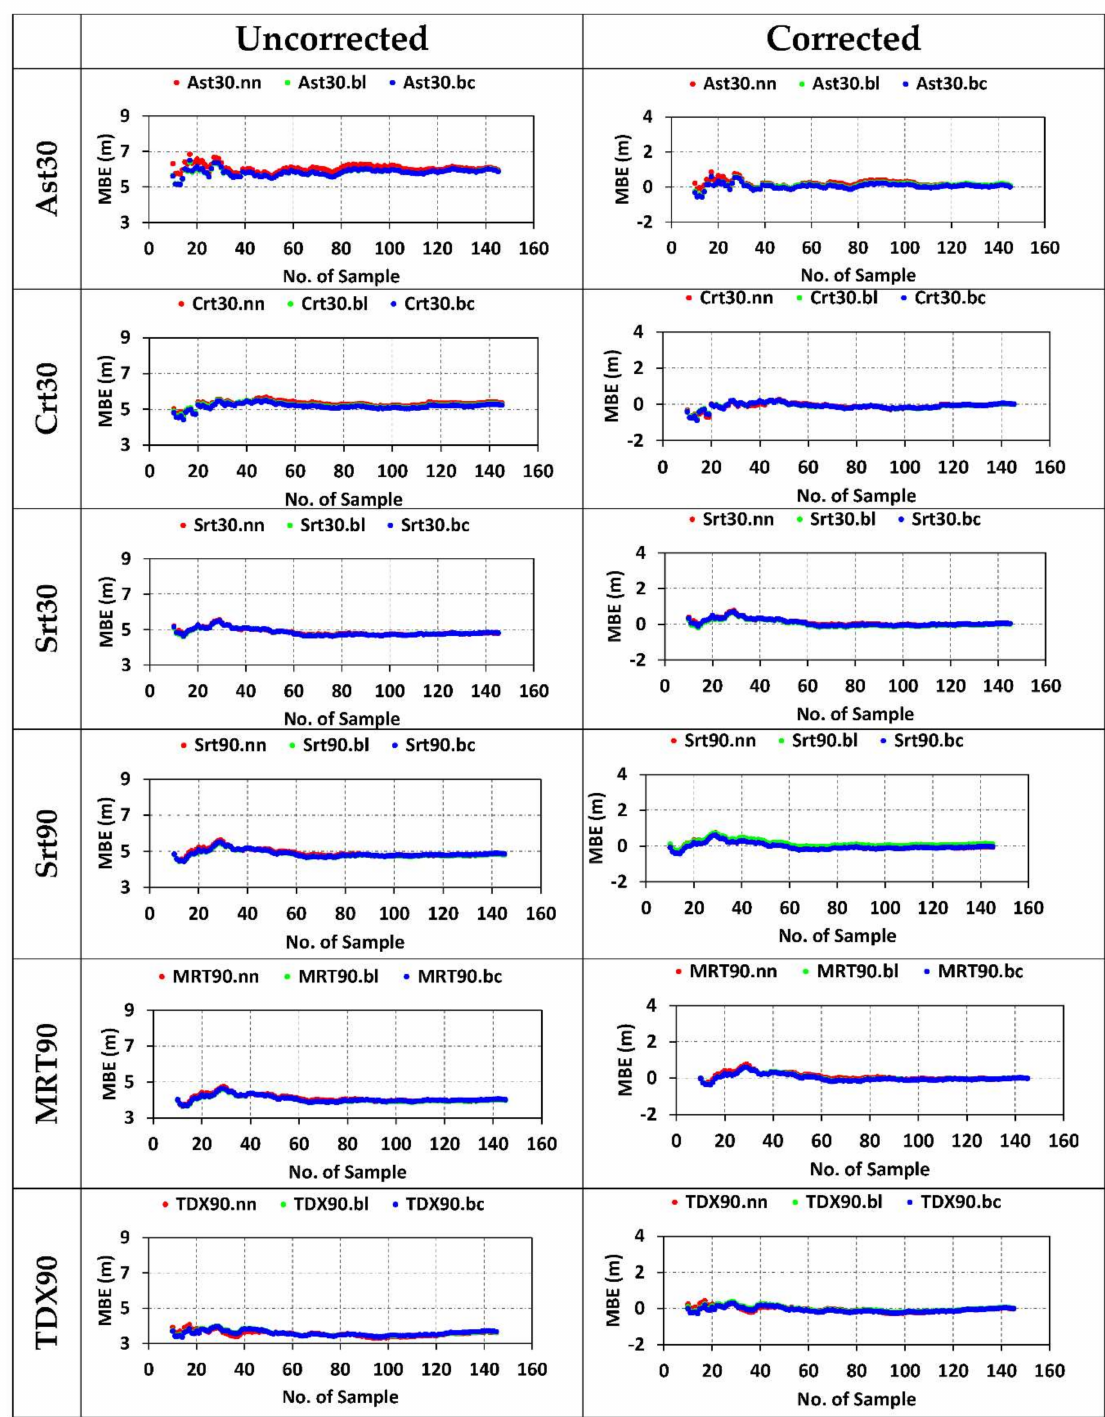
Figure 6. The variation in the calculated values of mean bias error (MBE) with increasing number of GCPs (randomly selected) exhibit substantial drop in the MBE up to approximately 40–60 GCPs (Ast30, Srt30) and, thereafter, remains nearly invariable (for 60–145 no. of GCPs). There is a sharp reduction in MBE for corrected space-borne elevation datasets (ASTER and SRTM). The nn, bl, and bc refer to the interpolation methods. (Ast30 = ASTER GDEM V3, Crt30 = CartoDEM v3.R1, Srt30 = SRTM.v3, Srt90 = SRTM.v4.1, MRT90 = MERIT DEM, TDX90 = TanDEM-X 90